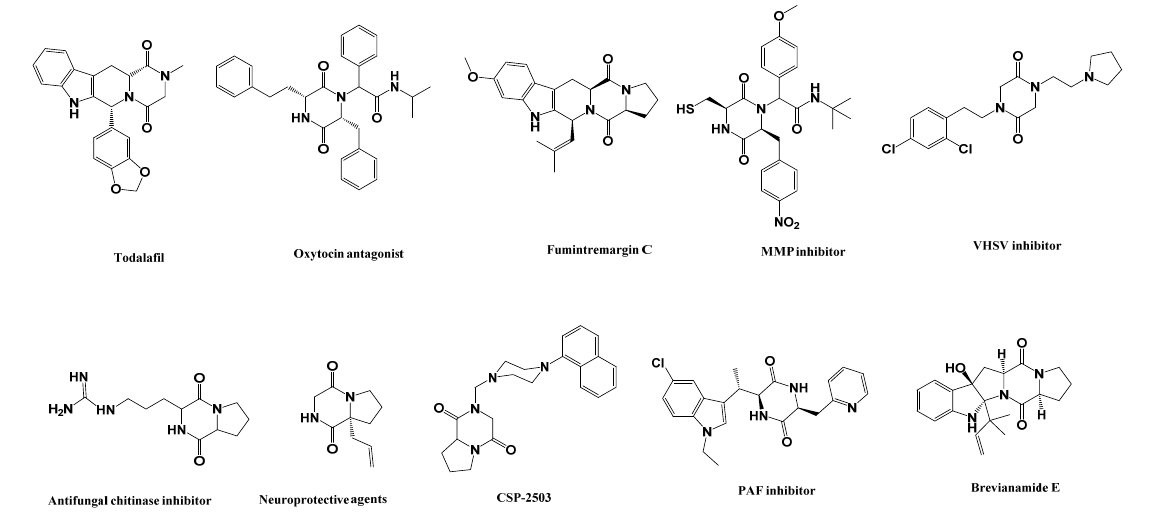
Figure 1. Biologically active DKPs.